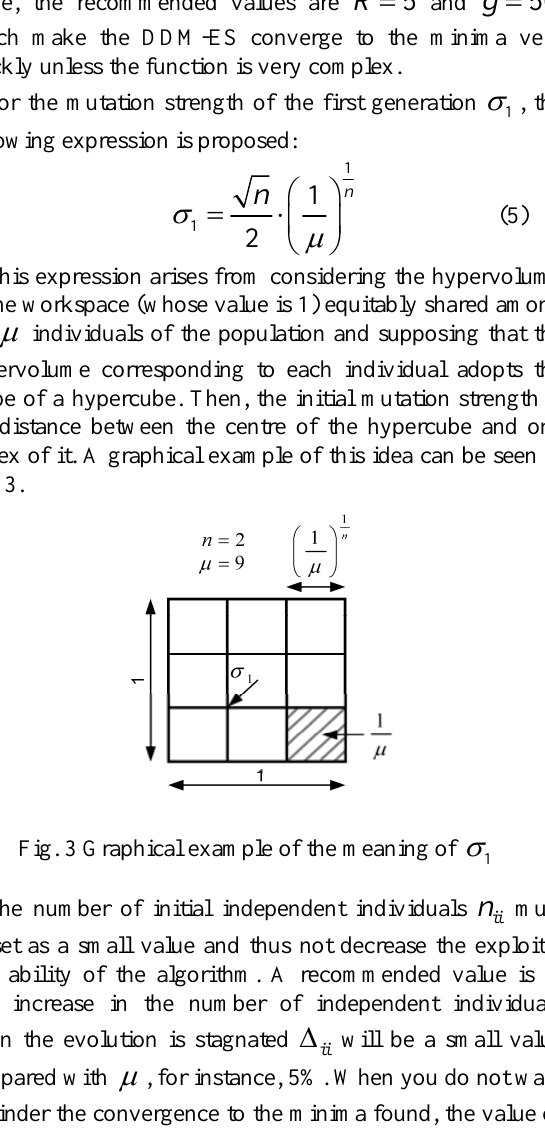
Table 2. Parameters for